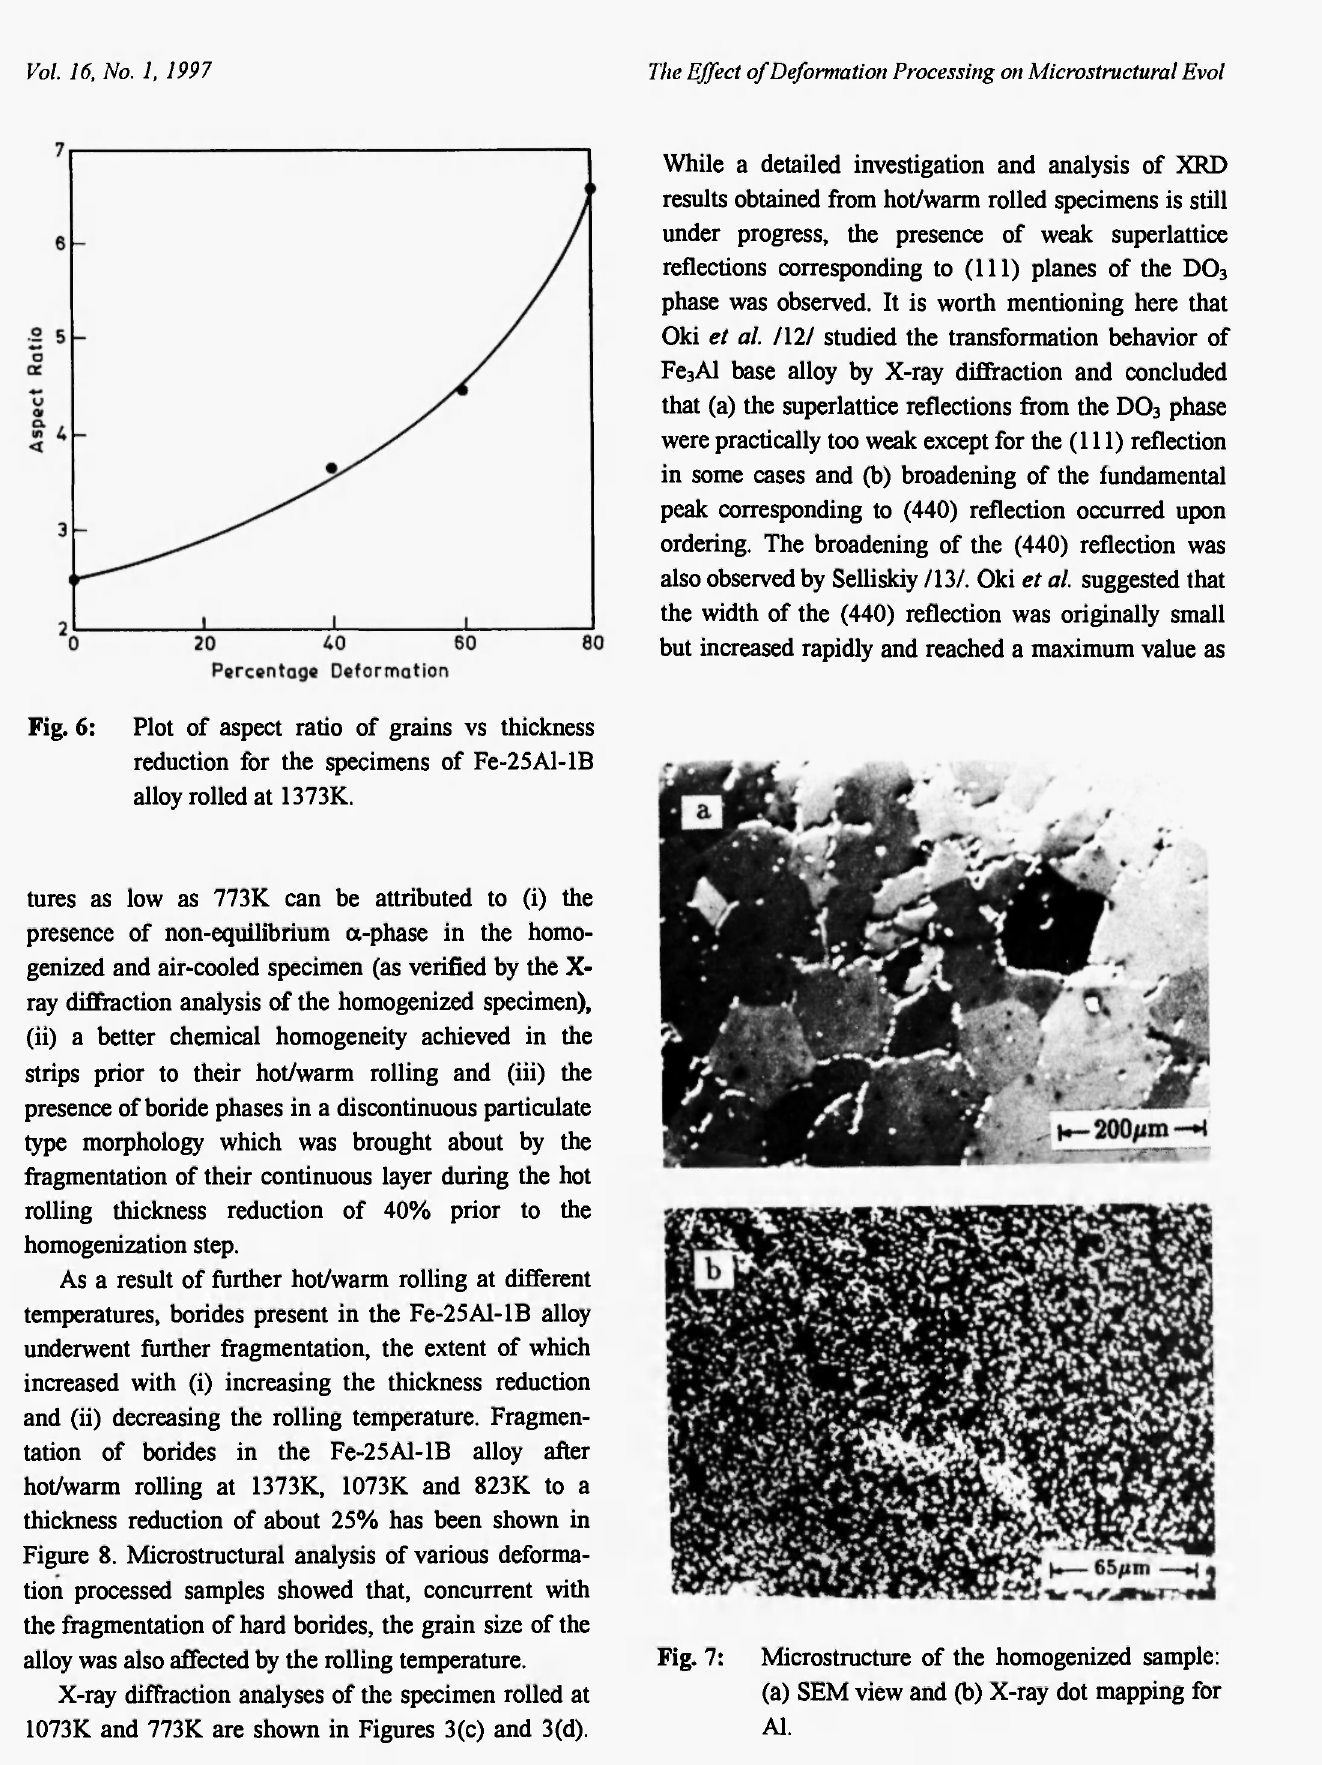
Fig. 7: Microstructure of the homogenized sample: (a) SEM view and (b) X-ray dot mapping for